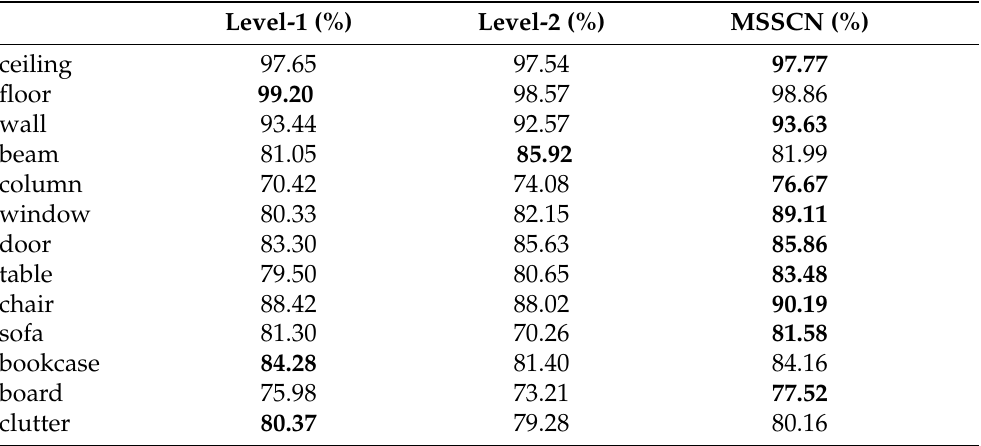
Table 2. Comparison of accuracy of each category on the S3DIS dataset